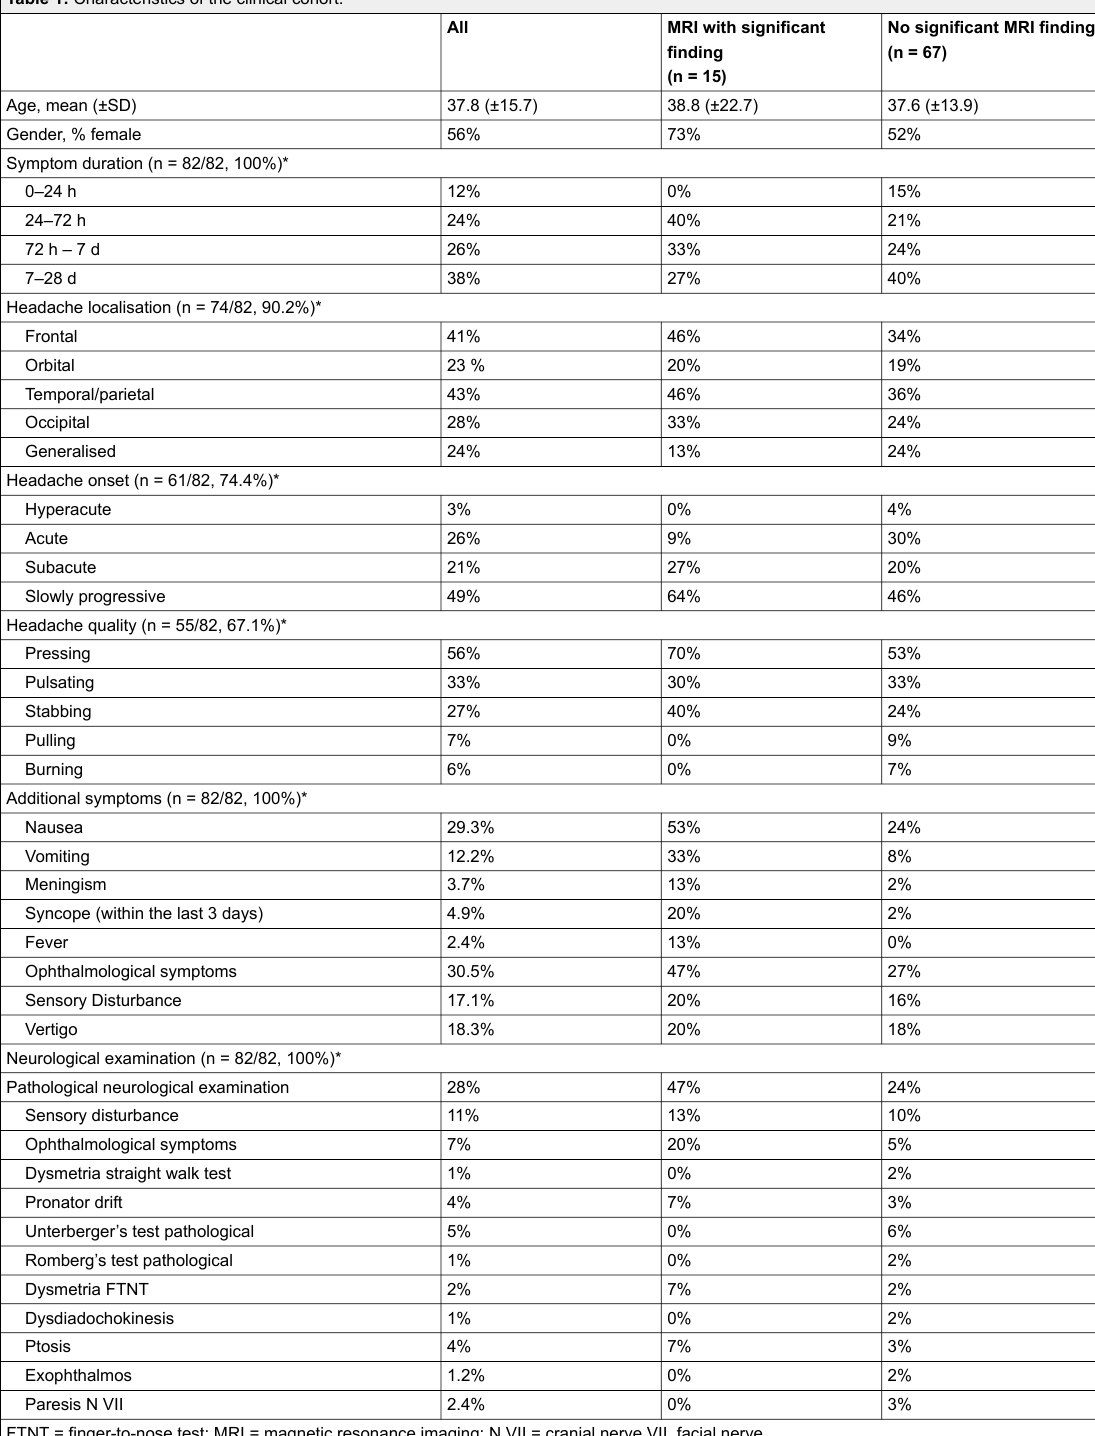
Table 1: Characteristics of the clinical